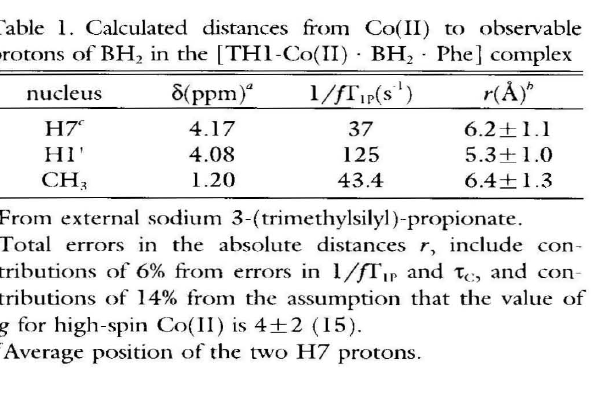
straints between L-Phe an infinite gands around the active site metal and a plausible structural model of L-Phe and BH2 simul taneously bound to the enzyme could not be